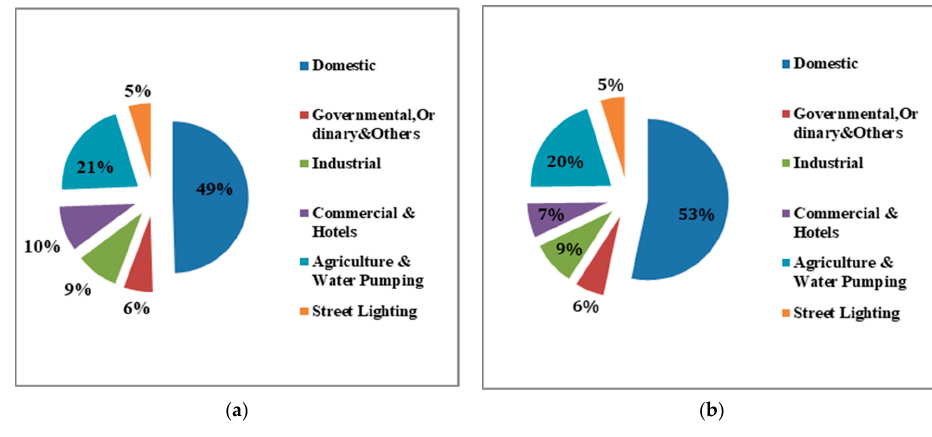
Figure 13. Electricity consumption by sector in IDECO’s area. ( a ) 2019, ( b ) 2020. The monthly percentage change in electricity consumption between 2019 and 2020